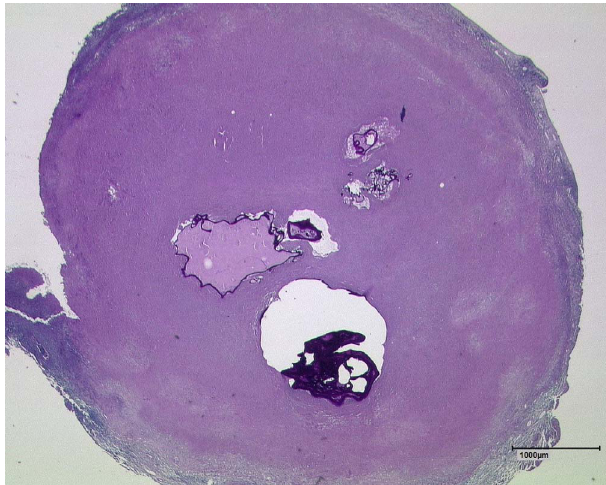
Figure 4. Section of a type IV AE lesion with central alveoli after PAS staining at 12.5 (cid:1) magni fi cation. Note the wide surrounding area of solid necrosis. (AE = alveolar echinococcosis, PAS = periodic